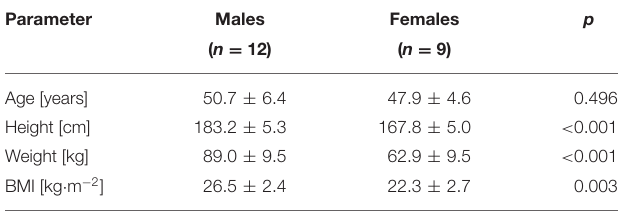
TABLE 1 | Demographic data of subject cohort.